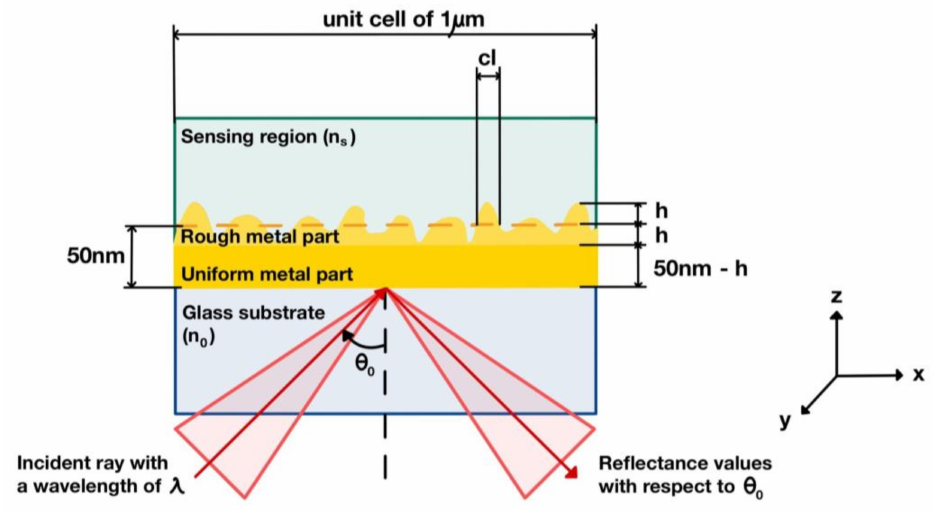
Figure 3. Simulation diagram including roughness parameters required for constructing rough surface